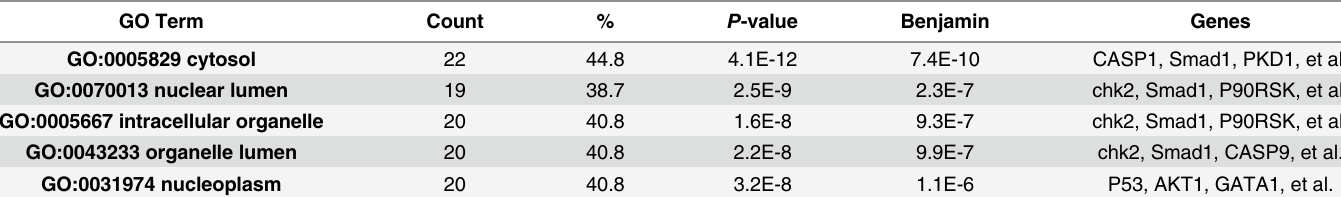
22.23±35.72 (Table 6). With the same method, our down-regulation PPI network displayed 17 nodes with an average path length of 2.04. Node degree was 3.65±2.47, and betweenness was 16.59±29.58 (Table 7). Proteins with high value were more important in the network and this suggested a central role in maintaining functionality and the coherence of signaling mecha- nisms. In our up-regulated PPI network, hub proteins with high node degree and betweenness ( > Means) were AKT1, CTNNB1, FOS, NFkB-p65, SYK, TP53 and MYC. On the other hand, the down-regulated network included BRCA1, LCK, AKT1, and TP53 (Fig 5). Notably, AKT1 and TP53 displayed the highest score for all computed centralities, suggesting its central regula- tory role in up-regulated proteins and in a down-regulated network. Table 4. Gene Ontology analysis (top five): cellular components.